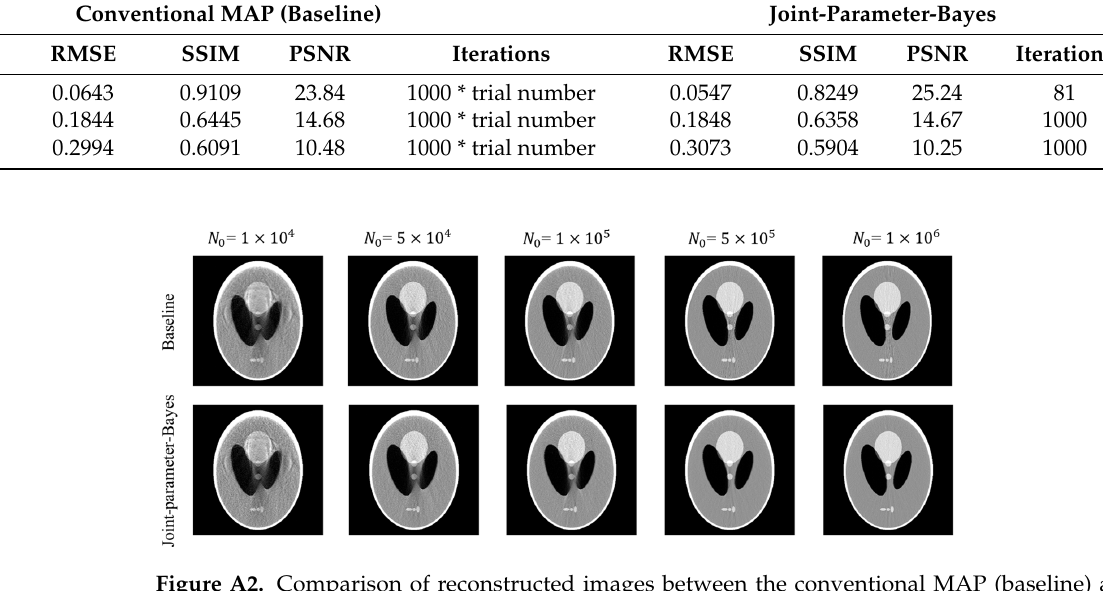
Figure A2. Comparison of reconstructed images between the conventional MAP (baseline) and joint ‐ parameter ‐ Bayes with Poisson noise to pre ‐ log transmission data. Table A2. Quantitative comparison of joint ‐ parameter ‐ Bayes with conventional MAP (baseline) with Poisson noise to pre ‐ log transmission data.